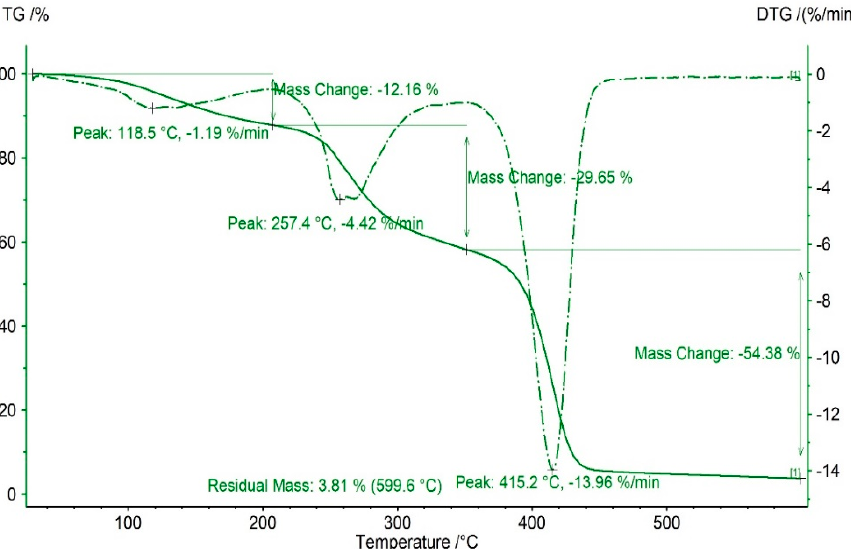
Figure 4. Thermogravimetric (TG) and derivative thermogravimetric (DTG) curve of water-borne polyurethane acrylate modified by hyperbranched silicon.